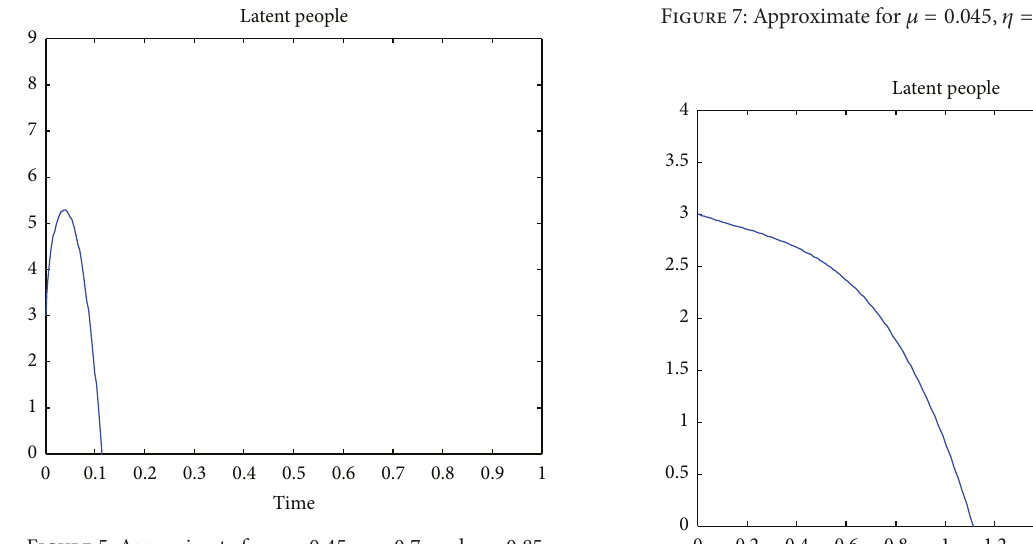
Figure 4: Approximate for 𝜇 = 0.45 , 𝜂 = 0.7 , and 𝜐 = 0.85 .